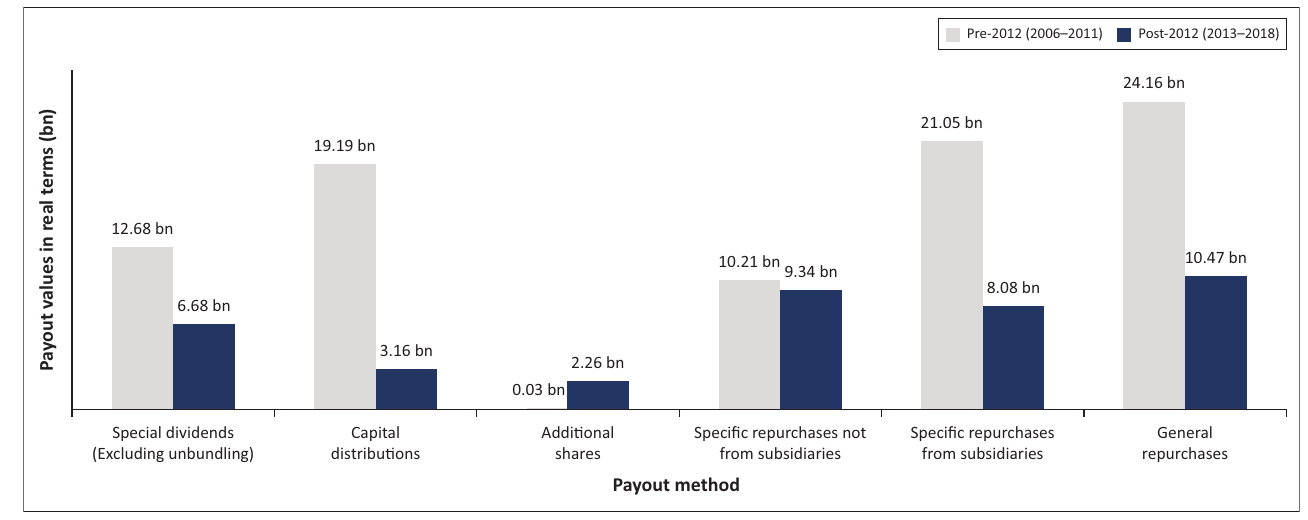
FIGURE 2: Payout methods other than ordinary dividends pre-2012 and